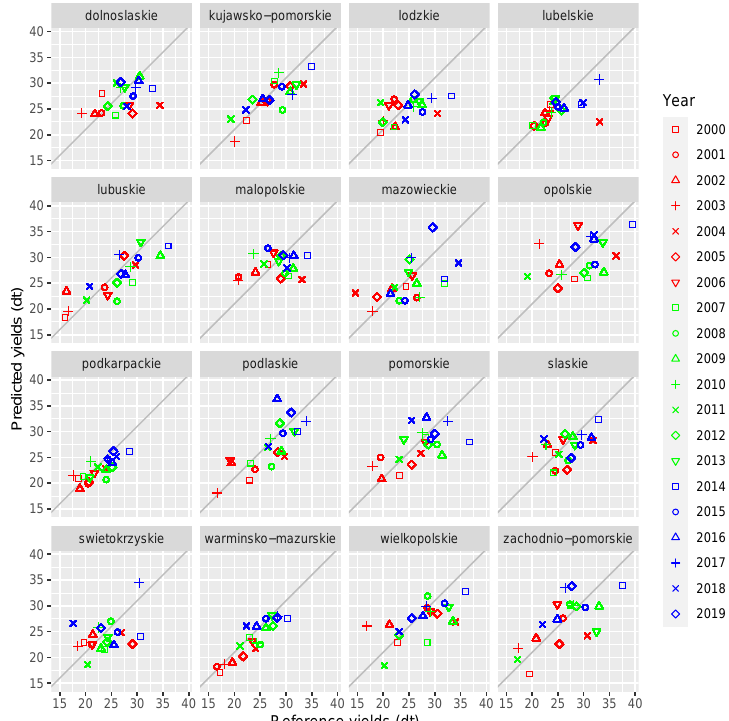
Figure 10. Comparison of crop yield predictions with the reference statistics for winter rapeseed at NUTS-2 level. The RMSE and bias of this relationship is given in Figure